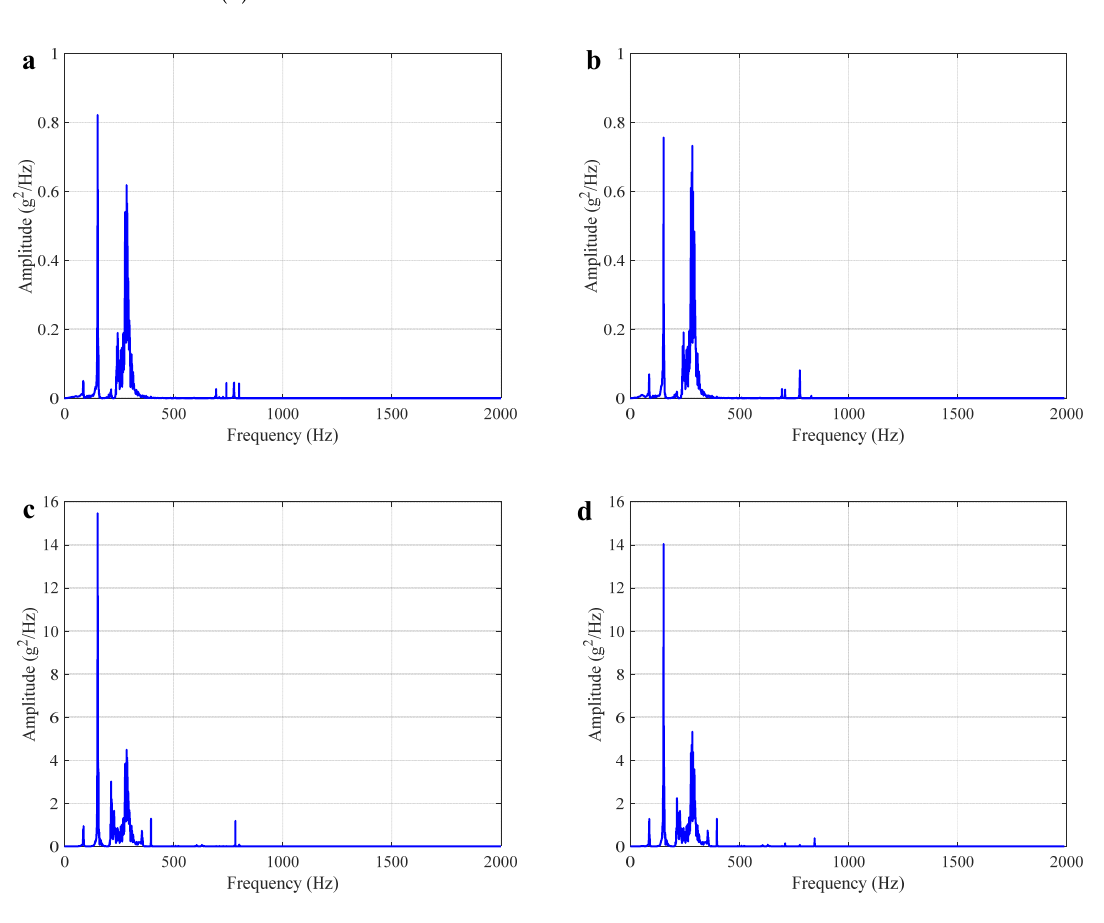
Figure 15. Measured random vibration response of experiment rack simulator. ( a ) Point A1. ( b ) Point A4.